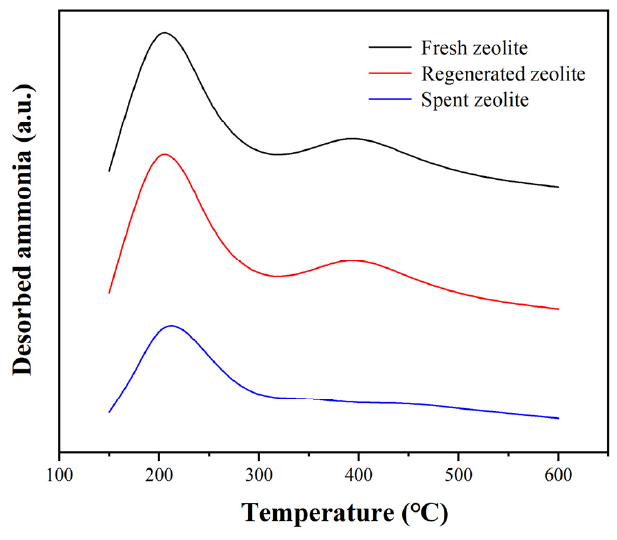
Figure 14. The NH 3 -TPD profiles of fresh, regenerated, and spent HZSM-5 zeolite.